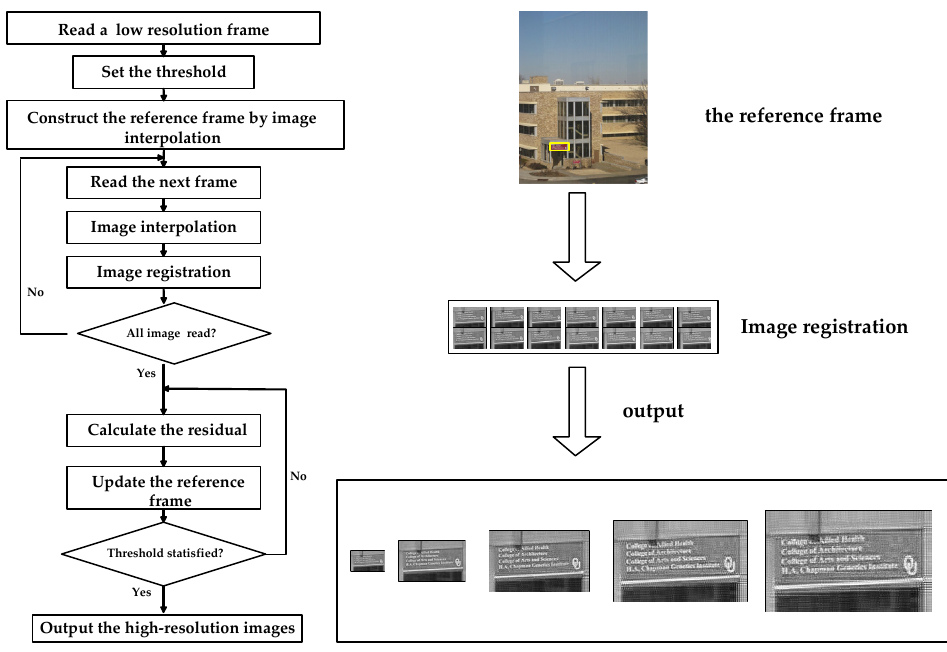
Figure 5. Super-resolution image reconstruction.